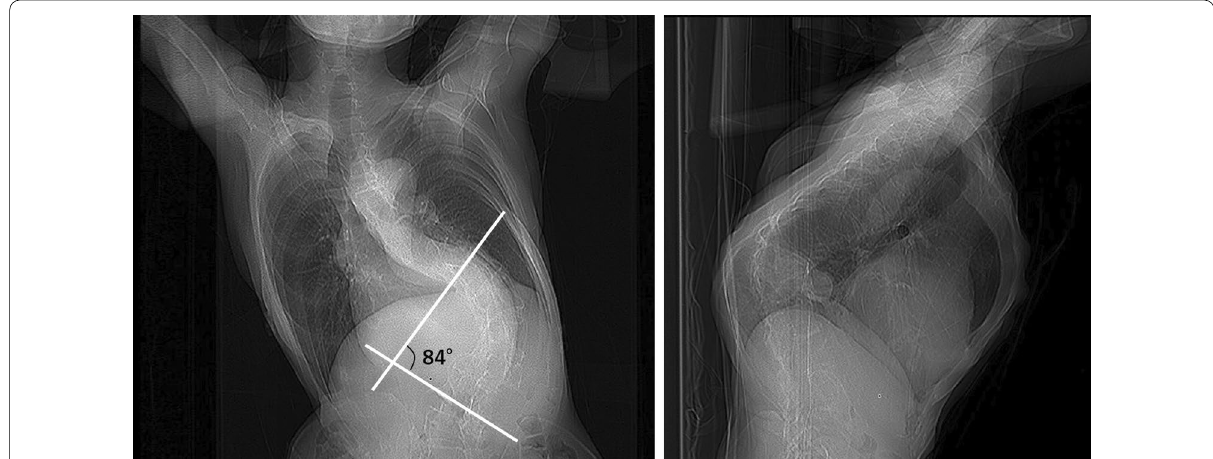
Fig. 1 Postero‑anterior and lateral chest X‑ray showing severe scoliosis (Cobb angle measurement of 84